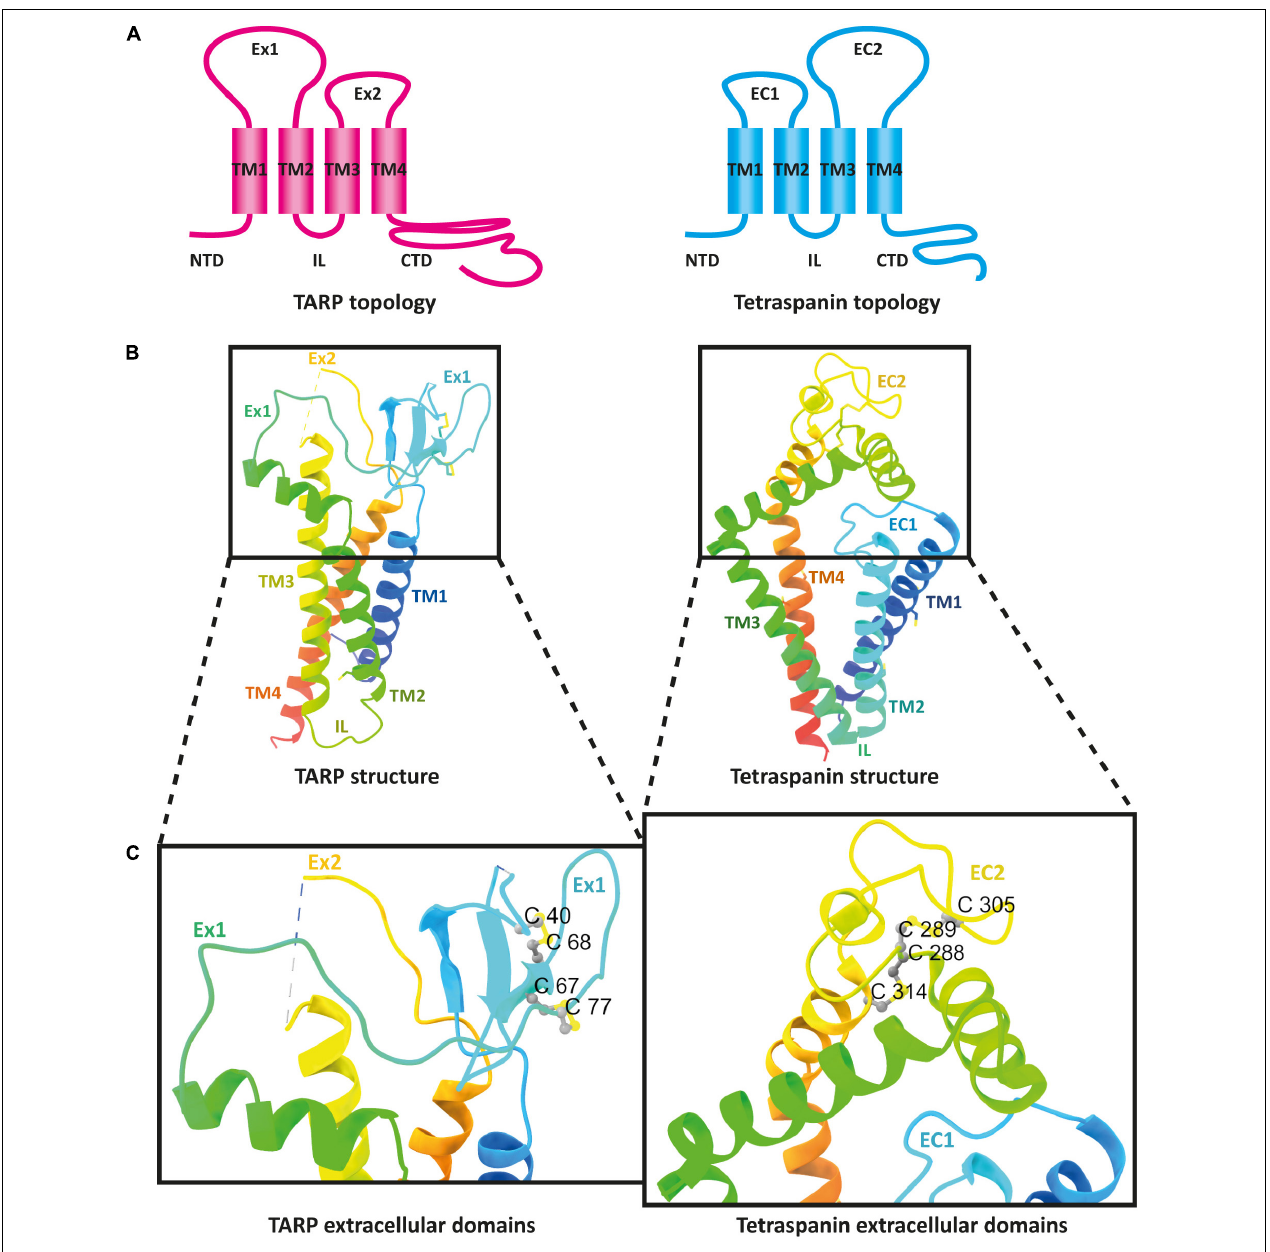
FIGURE 5 | The architecture of transmembrane AMPAR regulatory proteins (TARPs) and tetraspanins (TSPANs). (A) Overall topology of TARPs (left) in comparison to tetraspanins (right). (B) Ribbon diagrams, rainbow-colored (from N-terminus in blue to C-terminus in red), representing the structures of TARPs (left) based on the structure of human TARP γ 2, originally named stargazin and resolved by cryo-EM (pdb model 6DLZ, published by Twomey et al., 2018), and human Tspan25 (right), also known as CD53, resolved by crystallization and X-ray diffraction (pdb model 6WVG, published by Yang et al., 2020). Cysteine residues and disulfide bridges are presented as yellow heteroatoms and sticks, respectively. Distinct domains are labeled. Black boxes indicate the areas of TARPs and tetraspanins enlarged in panel (C) . Cysteine residues forming disulfide bridges in the big loops are labeled (one-letter amino acid code with number of each residue) and presented in ball and stick style with sulfur and carbon shown in yellow and gray,